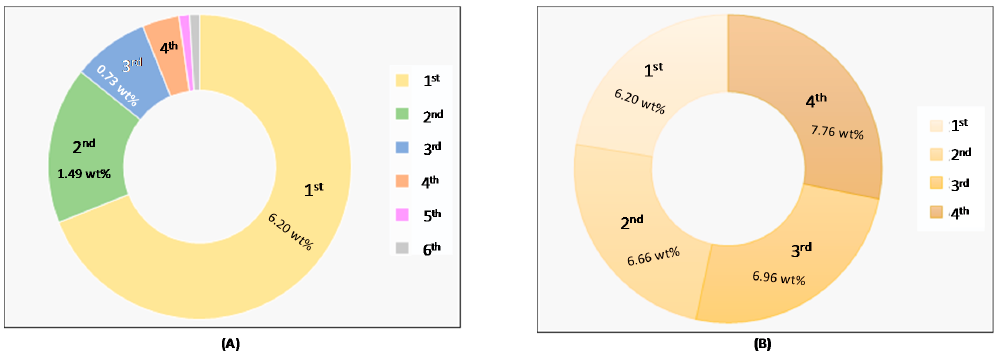
Figure 5. Cynaropicrin extraction yields from C. cardunculus leaves with the biomass ( A ) and solvent ( B ) recycle at fixed conditions: 70 wt % of water in decanoic acid:[N 4444 ]Cl (2:1), T = 25 °C, t = 60 min ( B ) recycle at fixed conditions: 70 wt % of water in decanoic acid:[N and S/L ratio =